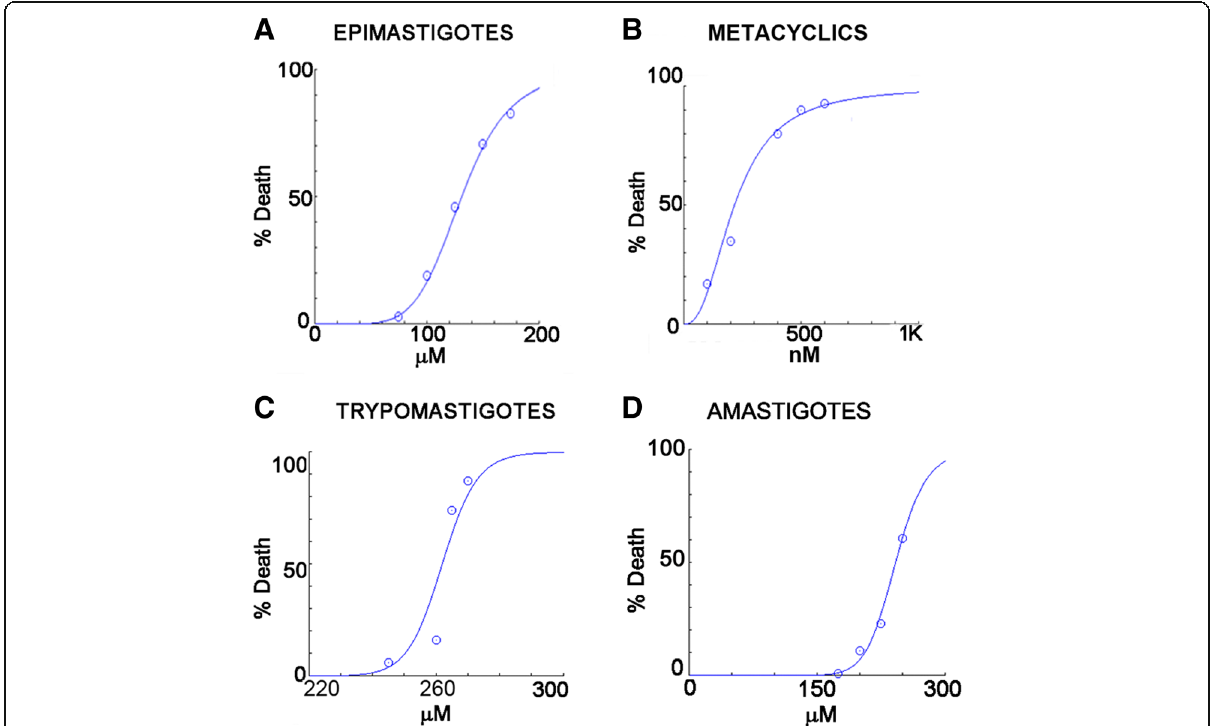
Fig. 1 Effect of 2-BP on different Trypanosoma cruzi developmental forms. a Effect on epimastigotes. IC 50 value was estimated as 130 μ M. n = 3, p < 0.001. b Effect on metacyclic trypomastigotes. IC 50 /24 h value was estimated as 216 nM. n = 3, p < 0.001. c Effect on culture trypomastigotes. IC 50 /4 h value was estimated as 262 μ M. n = 3, p < 0.001. d Effect on isolated intracellular amastigotes. IC 50 = 242 μ M. n = 3, p <